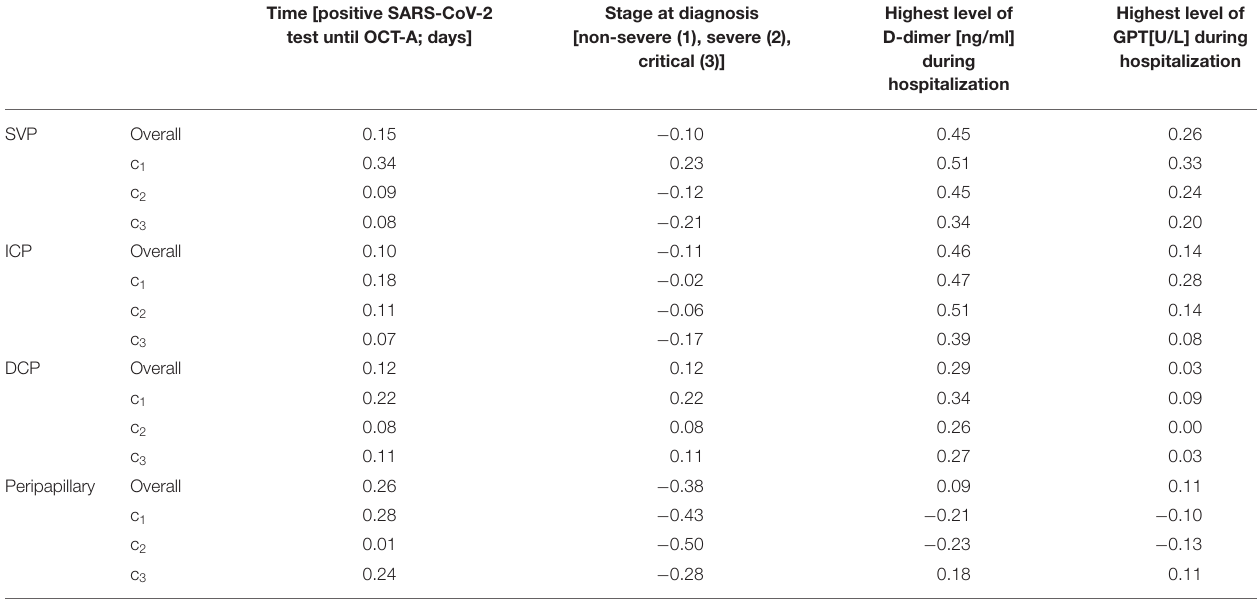
TABLE 5 | Correlation analysis of clinical data during hospitalization and vessel density in SVP, ICP, and DCP: time between positive SARS-CoV-2 test and OCT-A; stage at diagnosis (non-severe, severe, and critical) and the highest level of D-dimer and Glutamat-Pyruvat-Transaminase (GPT) during